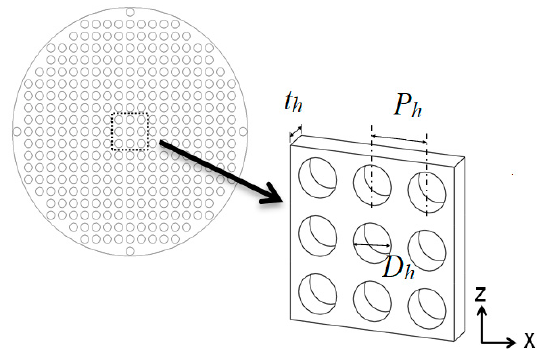
Figure 5. This figure illustrates the top view of the perforated structure of the sieve tray.